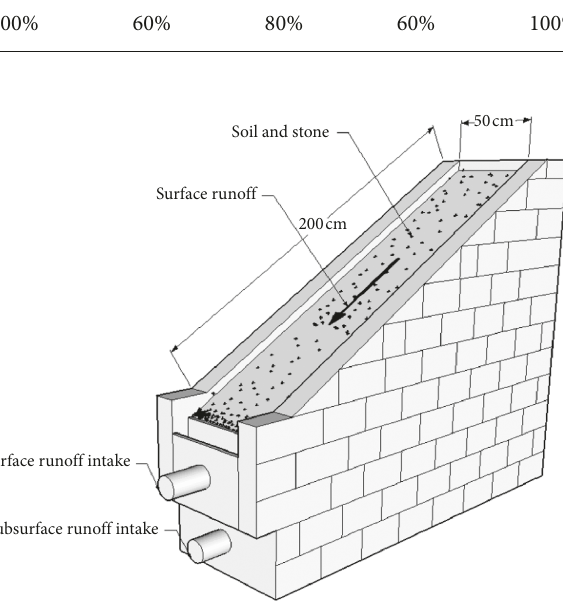
Figure 1: Schematic diagram of the experimental soil bin used in the simulated rainfall